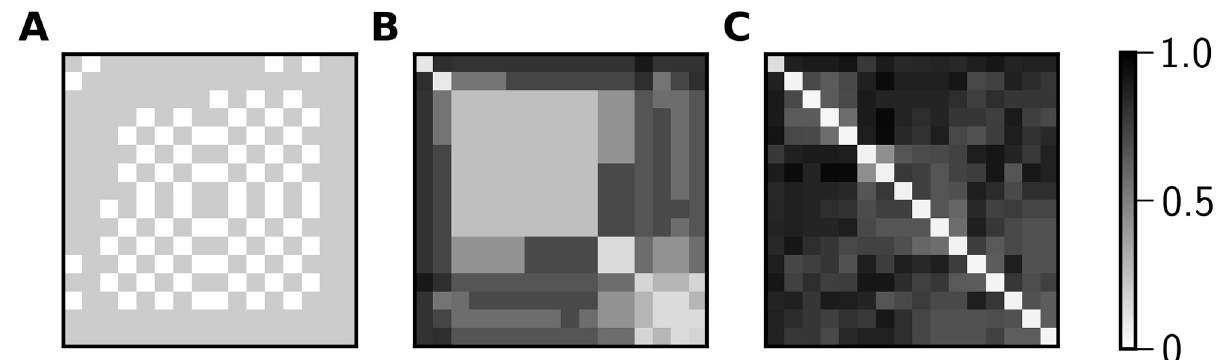
Fig 7. NCD matrices of temporally-regular, chimeric, and temporally-irregular network states. Calculation of the pairwise NCDs for the 16 nodes of the spike arrays shown in Fig 2 yields matrices that are indicative of three different network states. Both by ISI statistics and NCD, A is a temporally- regular state, B is a chimera state, and C is a temporally-irregular state.